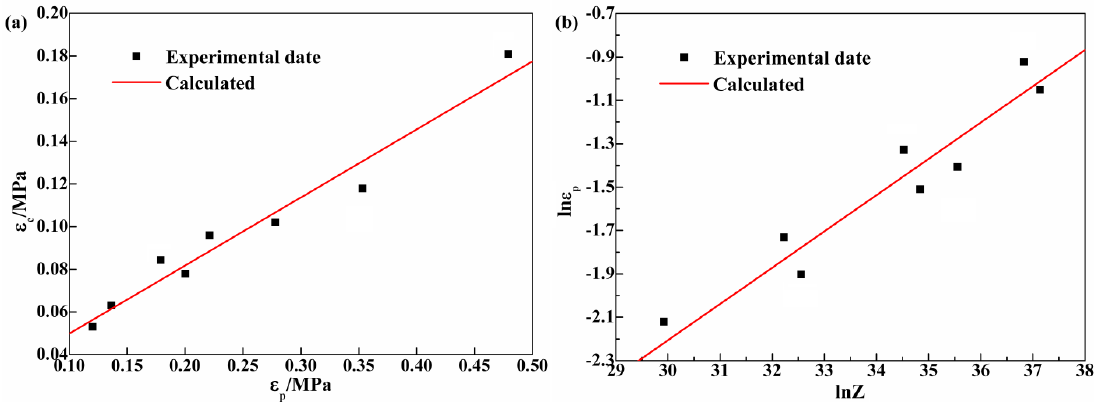
Figure 11. The plots of ( a ) ε c -ε p ; ( b ) lnε p -ln Z .